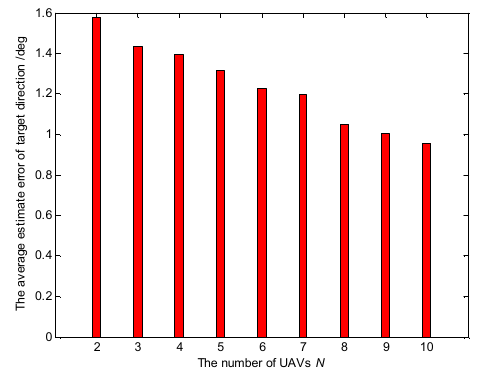
Figure 38. The average estimation error of target speed for different numbers of UAVs (Scenario 5).